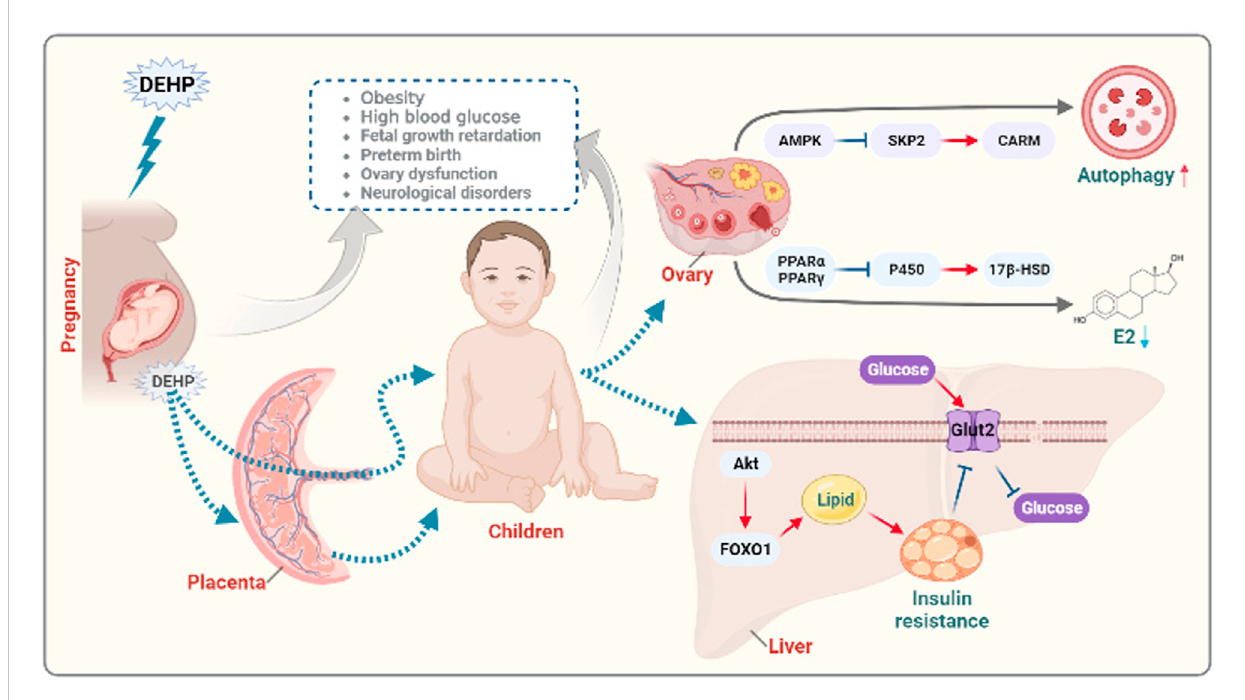
FIGURE 1 Diagram of the potential mechanisms of prenatal exposure to DEHP in offspring endocrine disorders. Functionally, DEHP could cross the placental barrier and directly or indirectly act on the fetus leading to growth retardation, preterm birth, ovary dysfunction and neurological disorders. Maternal exposure to DEHP could induce obesity and high blood glucose in offspring. Mechanically, maternal exposure to DEHP could activate AMPK-SKP2- CARM signaling to disrupt follicular development via autophagy in the offspring ovary. Moreover, DEHP can decrease P450 aromatase by activating PPAR α and PPAR γ , leading to the inhibition of ovarian secretion of hormones. Maternal DEHP exposure involving in regulating GLUT2 expression and in the liver leading to insulin resistance through FOXO1 signaling in immature male offspring. The fi gure was created with